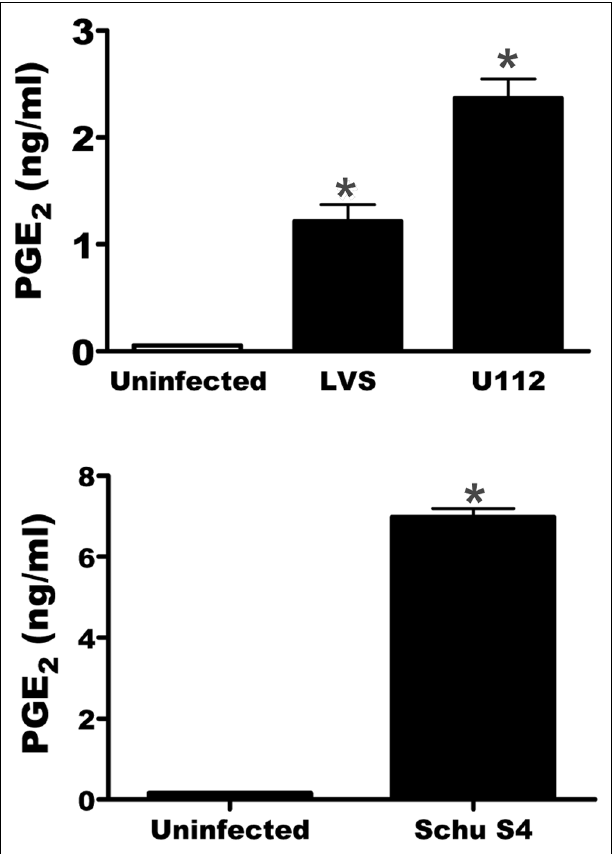
FIGURE 1 | U112 and Schu S4 induces the synthesis of PGE 2 from bone marrow-derived macrophages (BMDMs). BMDMs were either mock inoculated or inoculated with LVS, U112, or Schu S4 at an MOI of 200:1.Twenty-four hours after inoculation supernatants were collected and PGE 2 concentration was determined. Data represents three independent experiments and expressed as the mean ± SEM. Asterisk “*”denotes statistical difference ( p ≤ 0.05) from uninfected BMDM ( n =